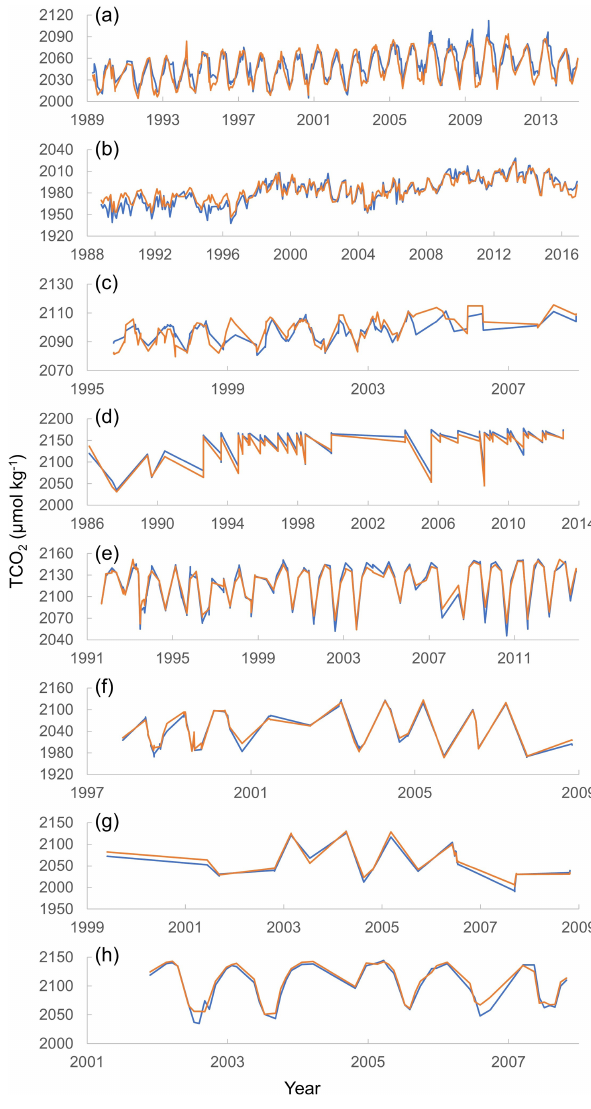
Figure 5. Measured (blue line) and computed (orange line) TCO 2 with NNGv2LDEO for the depth range 0–15m (0–30m in panel b ) for several time series. (a) BATS, (b) HOT ALOHA SURFACE, (c) ESTOC, (d) ICELAND, (e) IRMINGER, (f) KNOT, (g) K2 and (h)